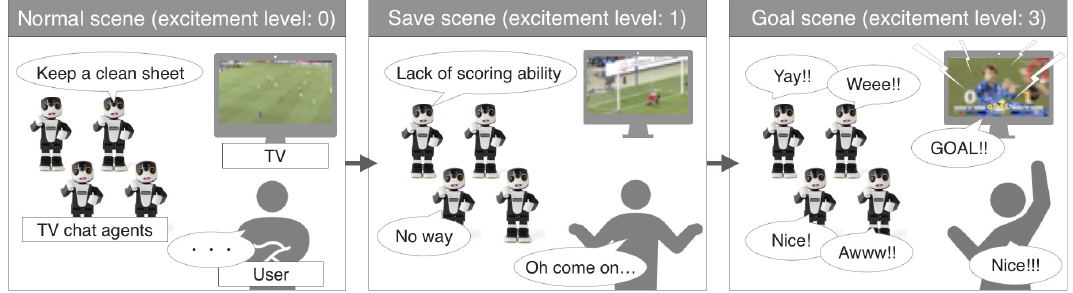
Figure 7. Examples of interaction between the TV chat agents and a user.